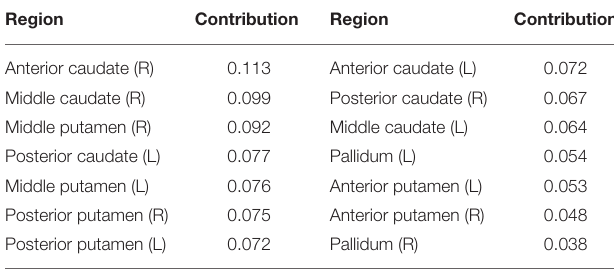
TABLE 6 | Relative contribution of different regions to the computer-aided classification framework. Region